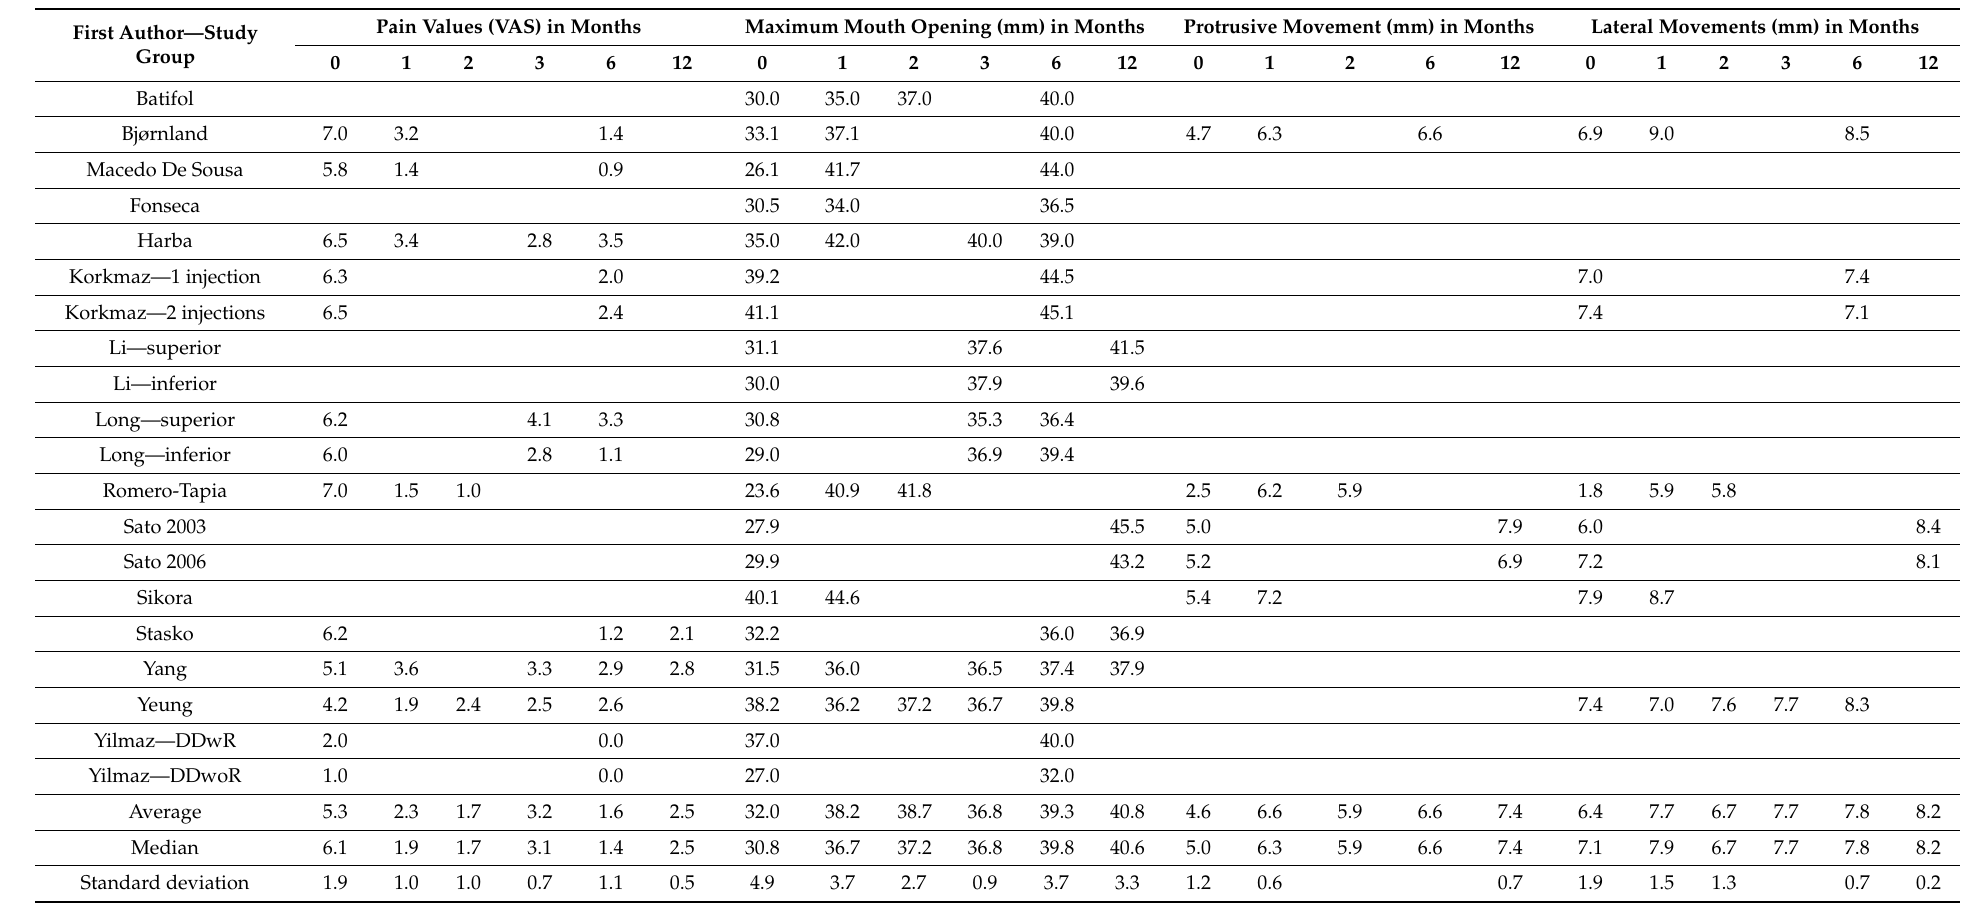
Table 6. Collective presentation of the results of studies included in the systematic